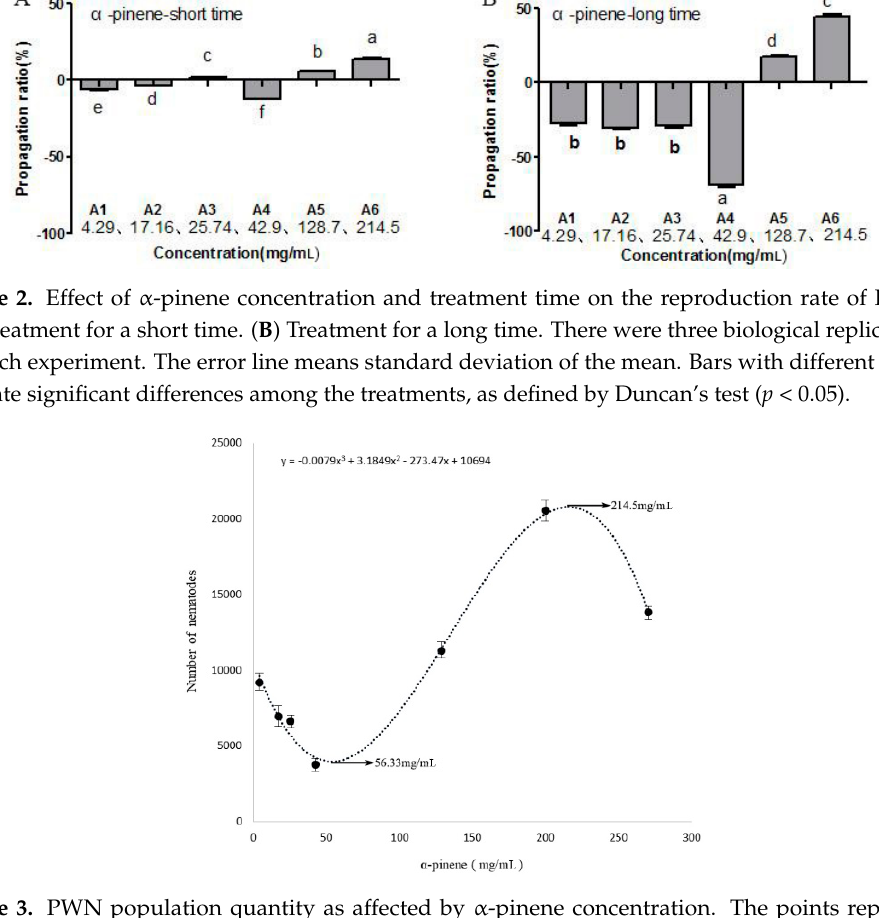
Figure 1. The mortality rates of the pine wood nematodes (PWNs) caused by different α -pinene concentrations. For each treatment, the mortality of PWNs exposed to α -pinene was corrected for the mortality of counterparts exposed to control using aqueous 0.5% Triton X-100 ( m / m ) solution. There were three biological replications for each experiment. The error line means standard deviation of the mean.